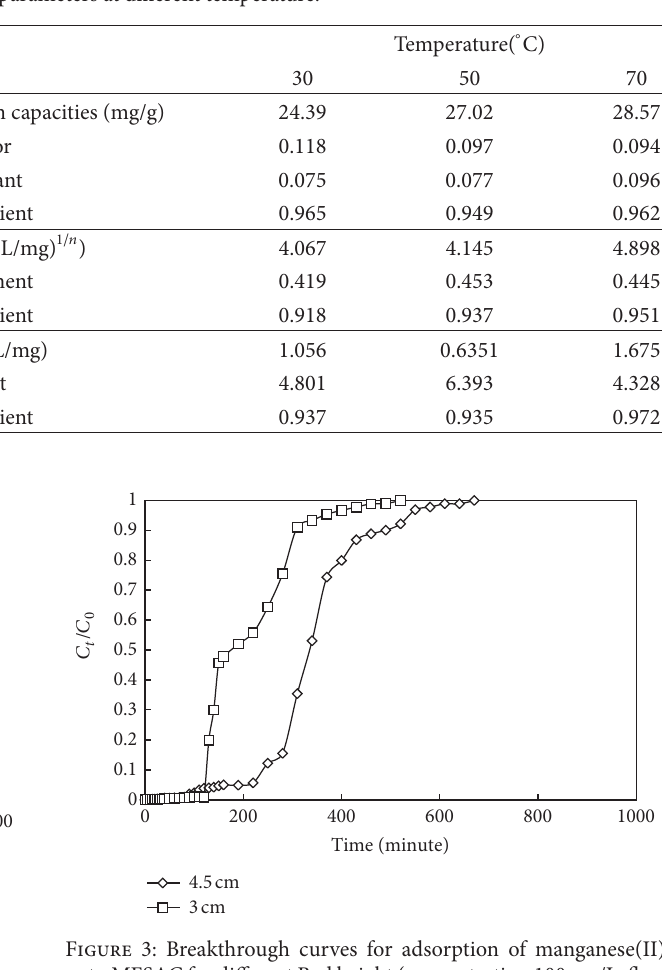
T 2: Isotherm model parameters at different temperature.